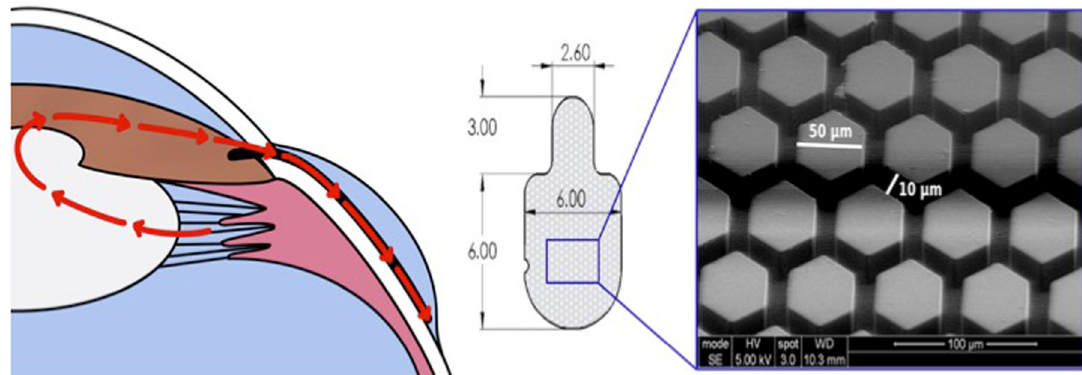
Fig. 1 Placement and structure of VisiPlate. A Anatomic placement of VisiPlate into the subconjunctival space. B Structure and dimensions of VisiPlate in millimeters, with scanning electron micrograph of VisiPlate ’ s surface topography of hexagonal corrugation and networked